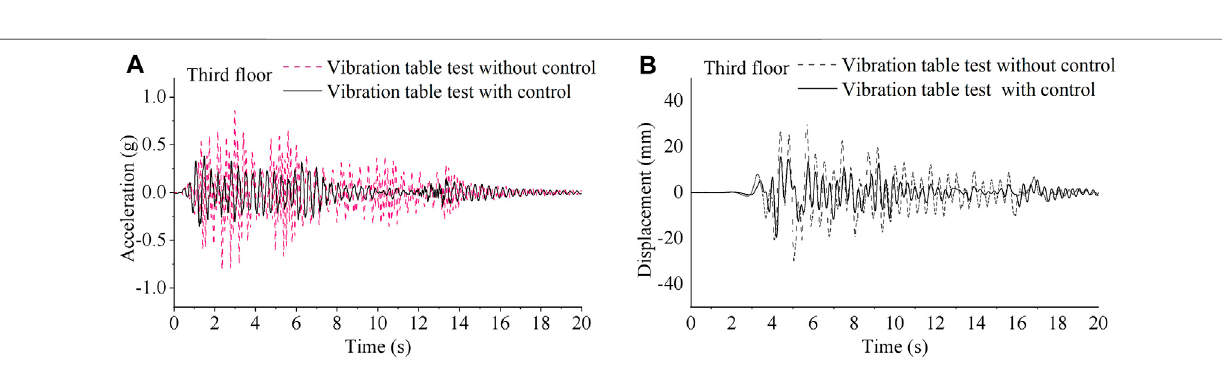
Frontiers in Materials |